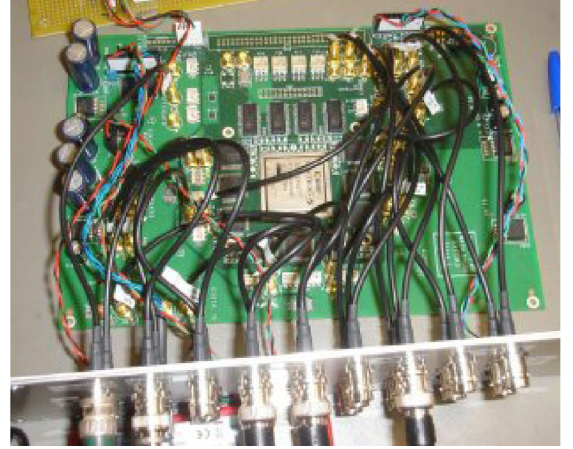
FIG. 8. Photograph of the FONT5A digital board with the case removed [28,29].